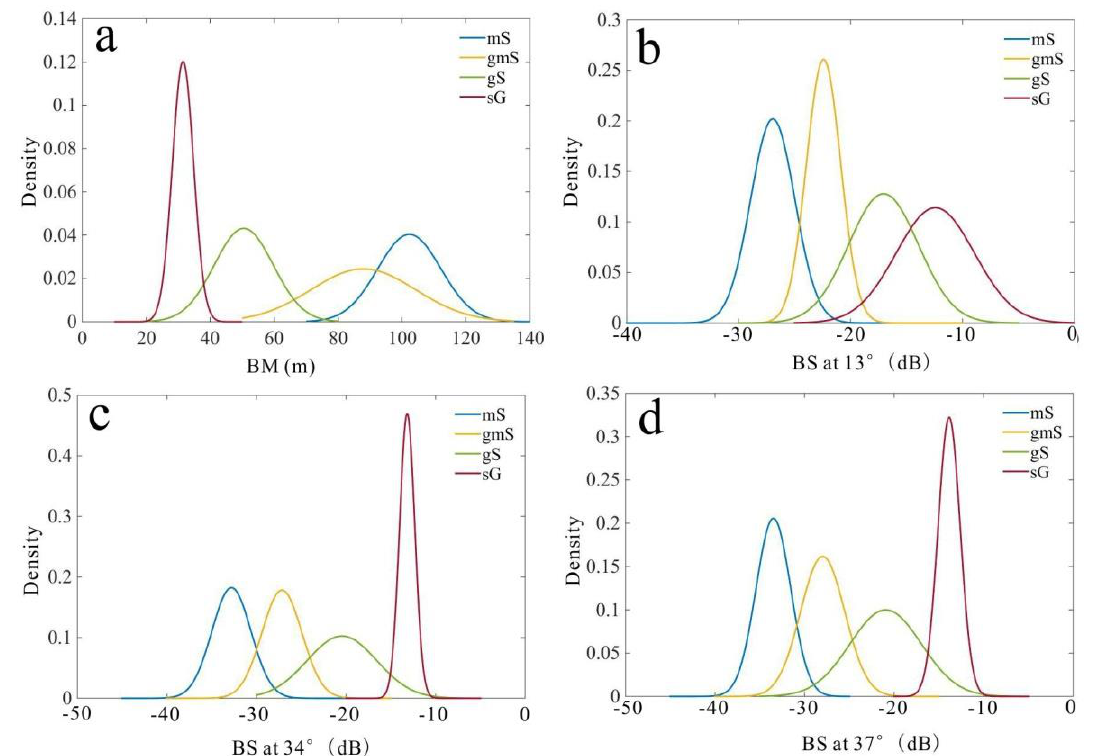
Figure 7. The probability density functions (PDFs) of measured BS and BM for sediment types. ( a ), The PDFs of sediment types and BM; ( b ), The PDFs of sediment types and BS at 13°; ( c ), The PDFs of sediment types and BS at 34°; ( d ), The PDFs of sediment types and BS at 37°.